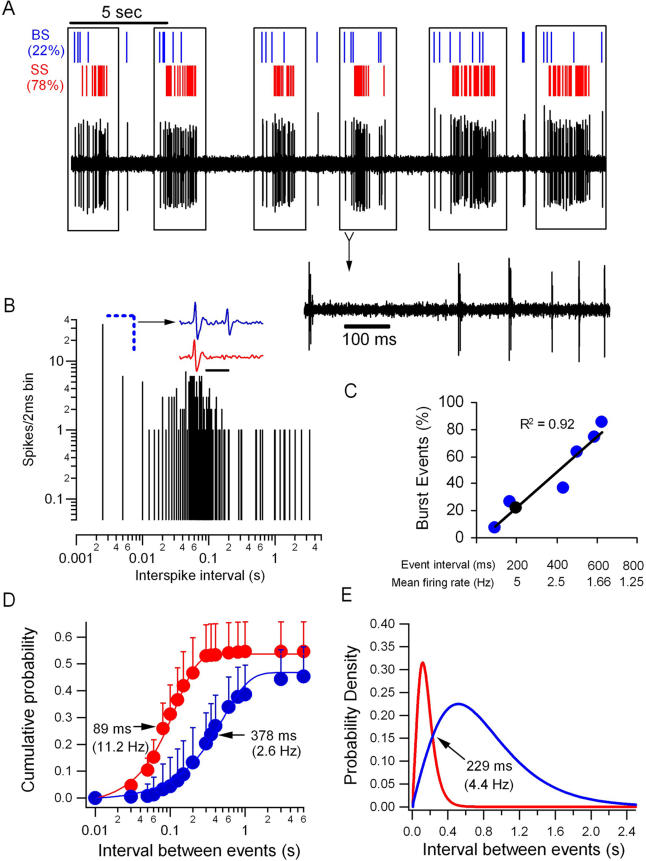
In Vivo Action Potential Output Mode Transition in Bursting Dorsal Subicular Neurons(A) Representative 30-s trace shows six epochs of bursting-to-single spiking output mode transition. Each epoch began with bursts that switched to single spikes. Bursts (BS, blue) and single spike (SS, red) events were extracted from the raw data (black trace) for each cell, and the percentages of spike events (burst or single spikes) were determined. For this cell, 22% of the total events were bursts, while 78% of events were single spikes. The lower inset depicts an expansion from one epoch showing the transition from bursting to single spiking.(B) Interspike interval histogram for the neuron in (A) shows a bimodal distribution of short intervals of less than 8 ms (blue dashed lines show burst intervals), and of longer intervals between 40 and 200 ms. The arrow points to an expanded burst (blue) and single spike (red) extracellular waveform (scale bar, 2 ms).(C) A strong positive correlation was observed between the percentage of burst events and the average event interval (n = 7). The filled black circle shows the relative position of the cell from (A) and (B).(D) The cumulative probability plot shows the probabilities of total burst (45%) and single spike (55%) events across inter-event intervals for all cells (n = 7). A sigmoidal function was used to fit the data (half max SS [red] = 89 ms, BS [blue] = 378 ms).(E) Probability density plot shows the fractional probability change across the inter-event interval. The peak probability density for bursting (blue) was longer than for single spiking (red) events; the arrow indicates the interval beyond which the probability of bursting exceeds that of single spiking.